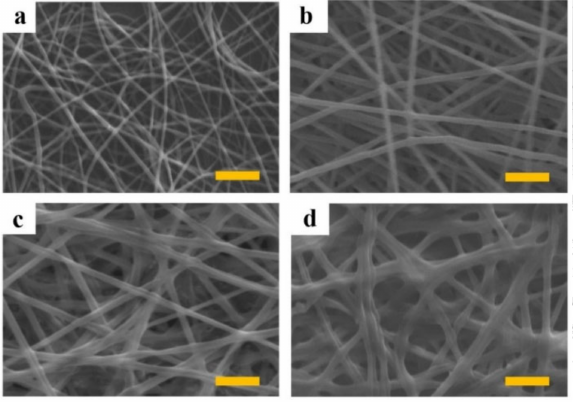
Figure 1. Scanning electron microscopic images of electrospun polyurethane (PU) single nanofiber ( a ) and PU core-PDLLA shell (1:1. 1:2 and 1:4) electrospun nanofiber ( b – d ). Yellow scale bar represents 5 µ